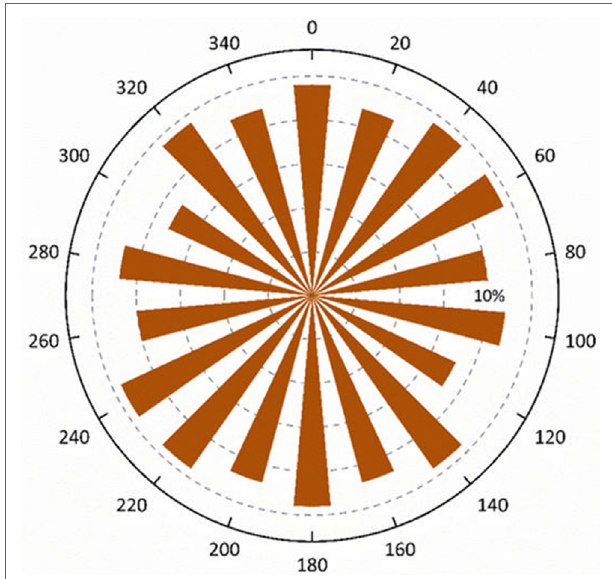
FigUre 5 | Rose diagram detailing the orientations of the silicon-dominant fibers found on the surface of the particles (arbitrary zero direction).